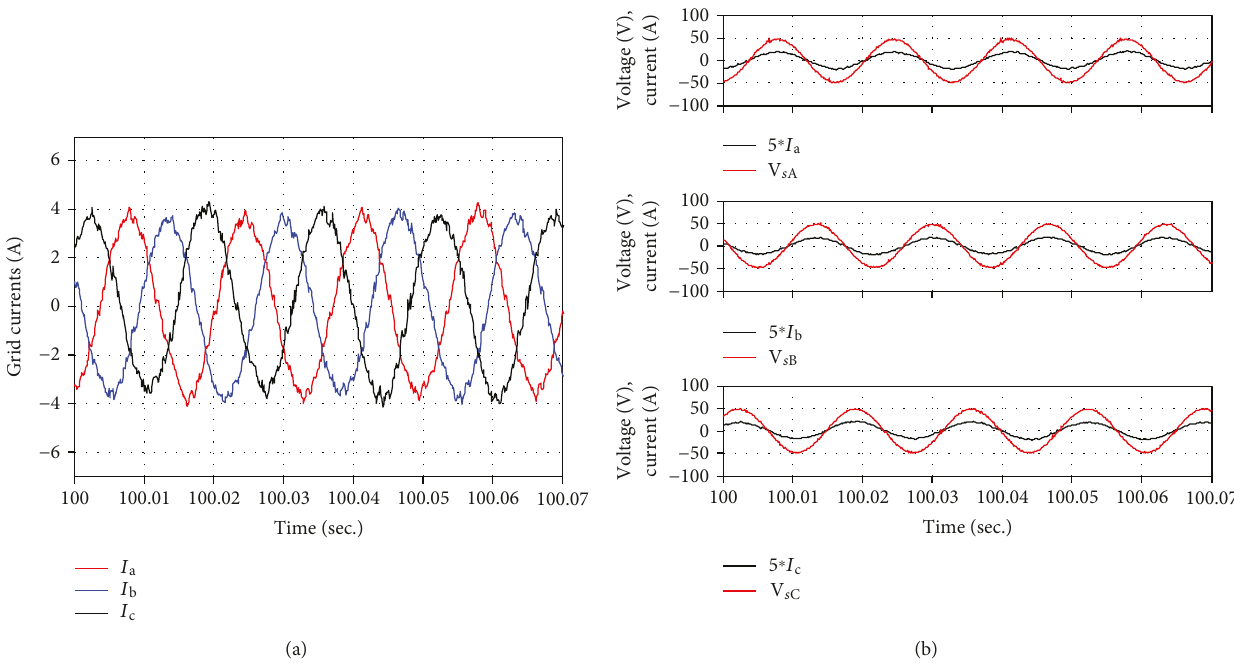
Figure 24: (a) Experimental three-phase grid currents of con fi guration B. (b) Experimental grid voltages and grid currents of con fi guration B.